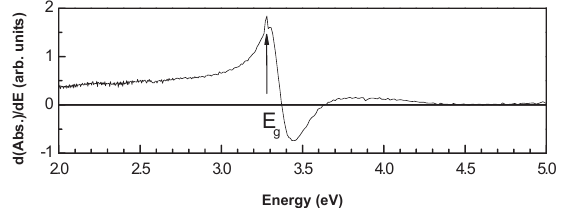
Fig. 5 First derivative absorption spectrum of the nanocrystalline ZnO flakes.